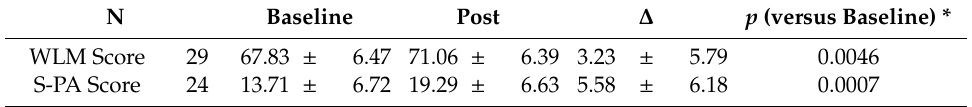
Table 3. Changes in the word list memory and standard verbal paired associate learning scores. N Baseline Post ∆